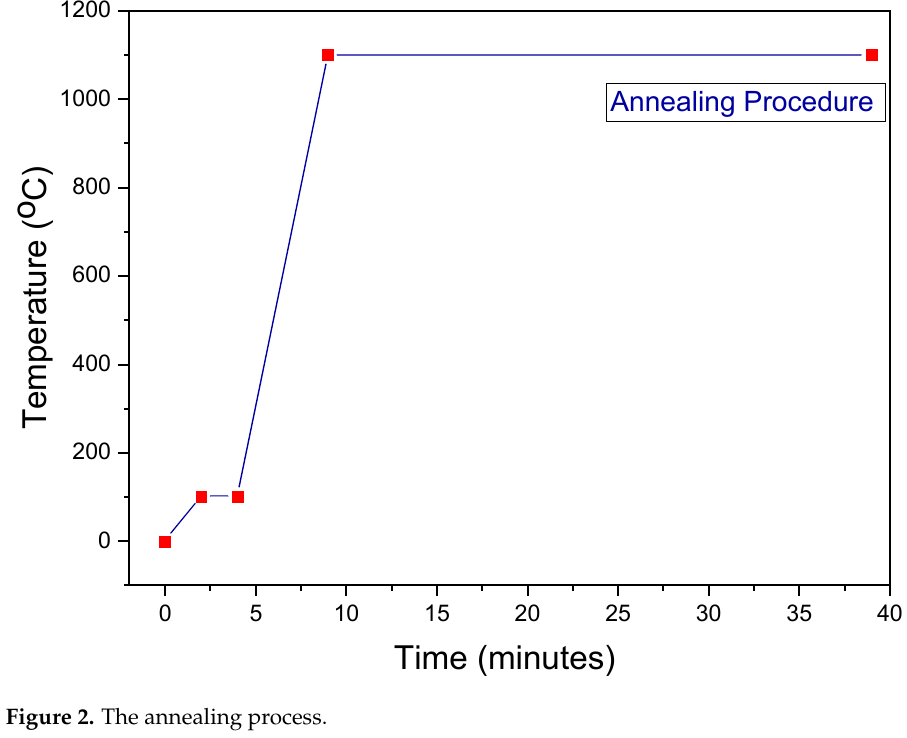
Figure 2. The annealing process.